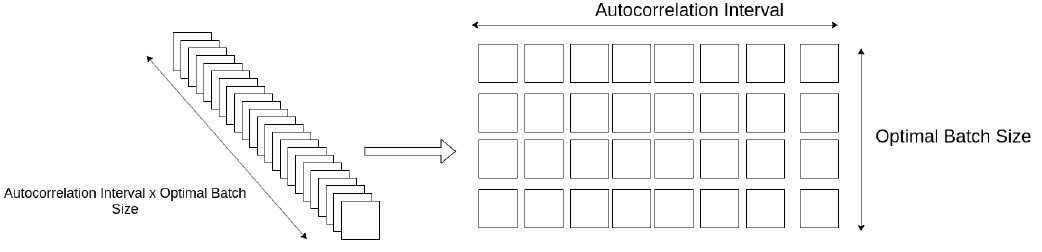
Figure 8. Data transformation.